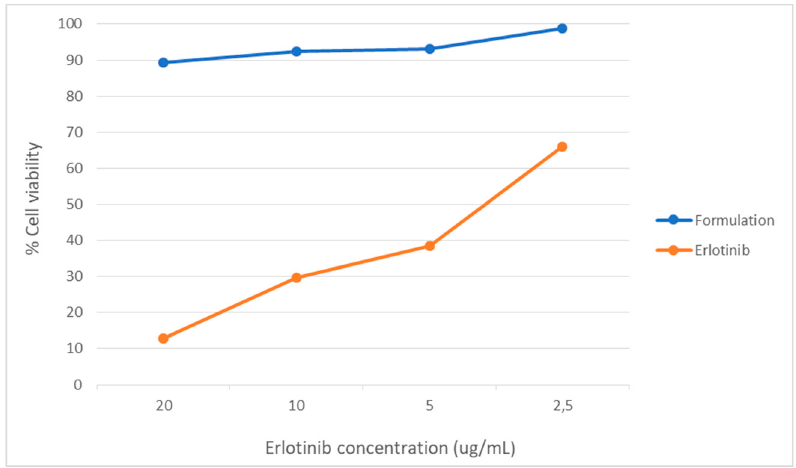
Figure 5. Viability caused by the Formulation and Erlotinib.